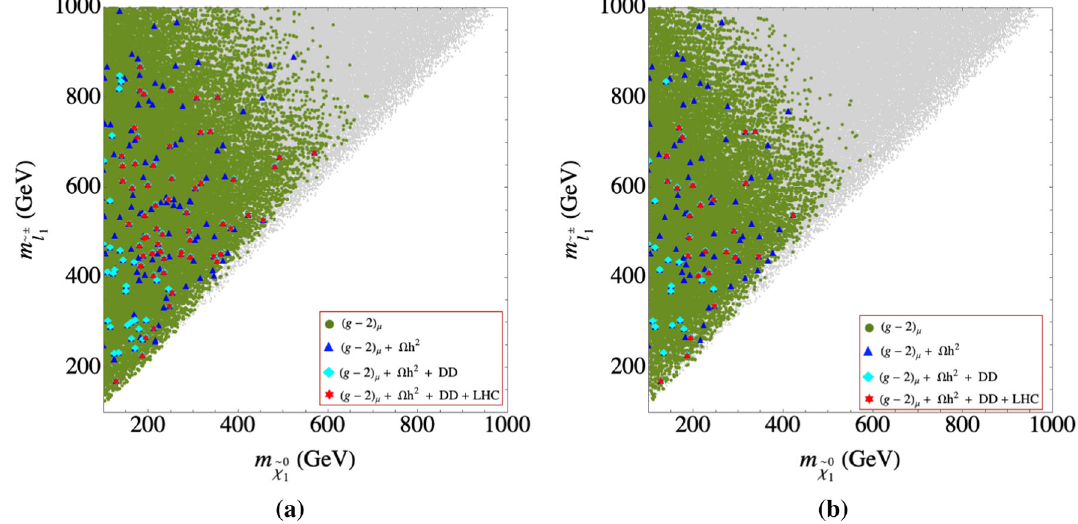
Fig. 5 The results of our parameter scan in the m ˜ χ 0 from ( g − 2 ) μ ). The color coding is as in Fig.